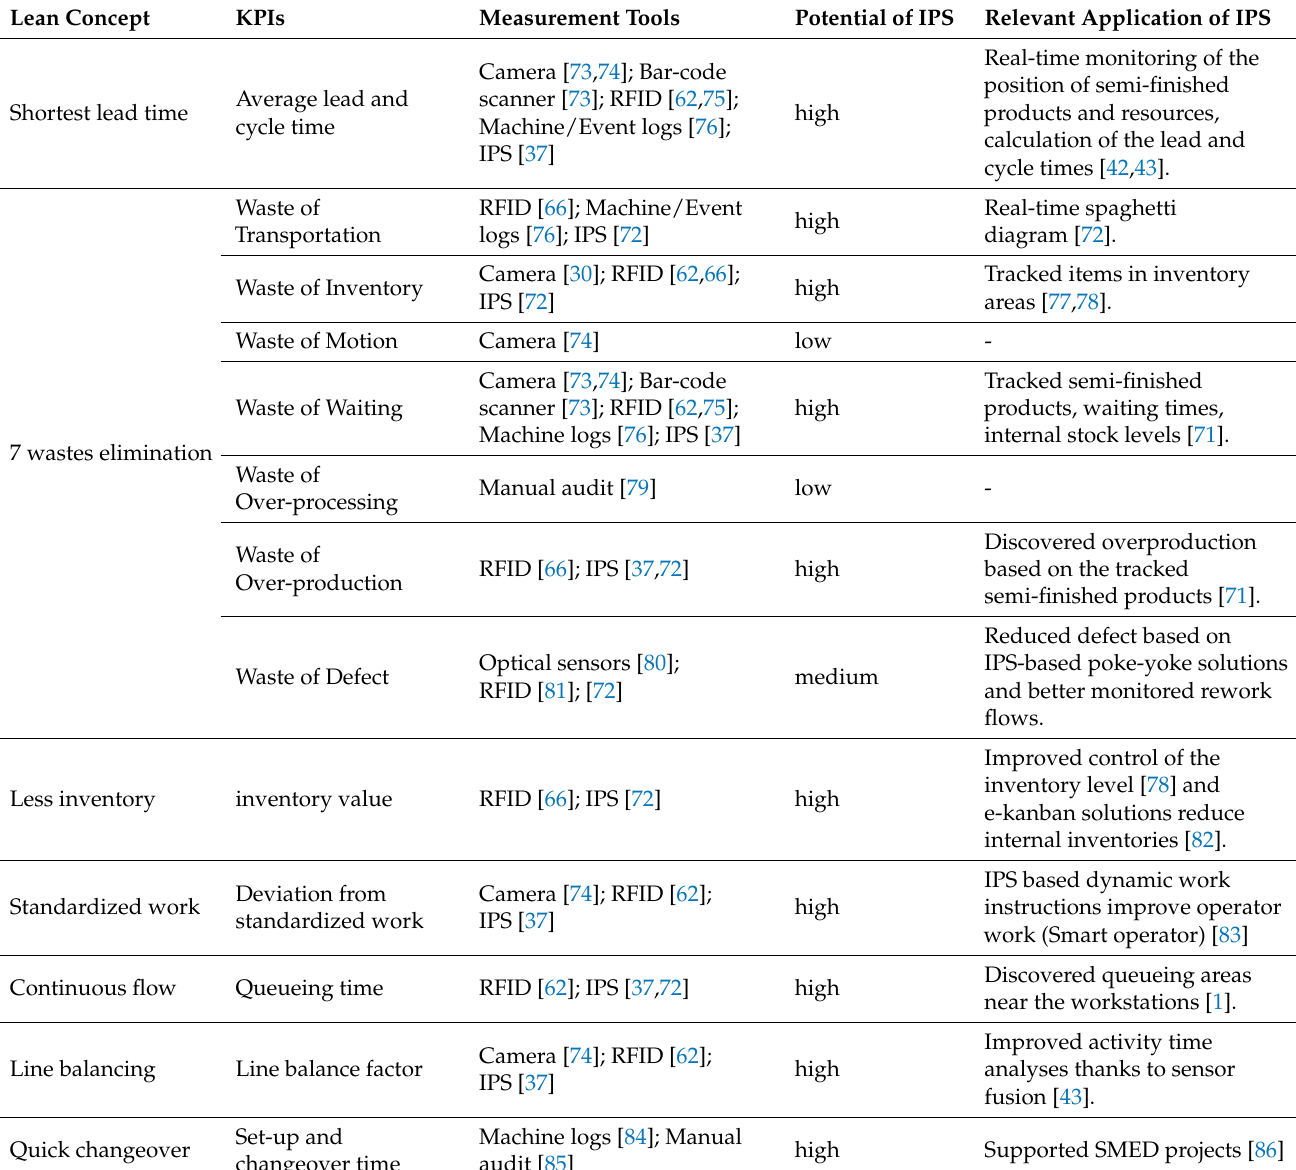
Table 1. The traditional concepts of LM with the potential of